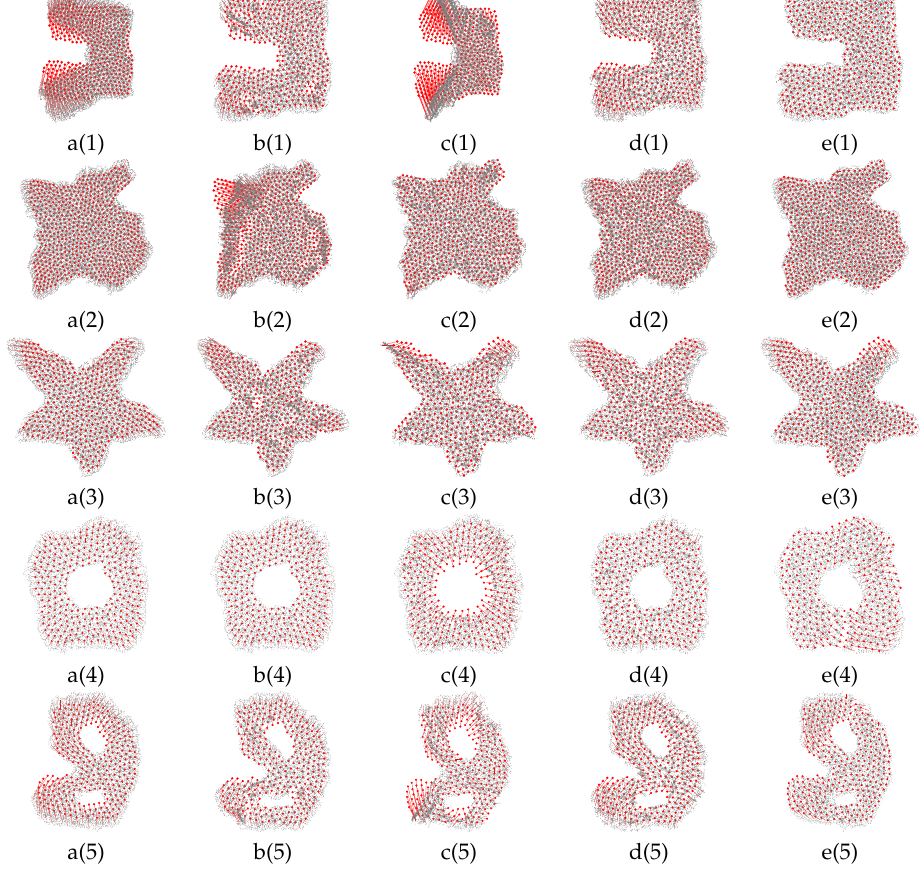
Figure 8. Comparison with other methods on networks with mere